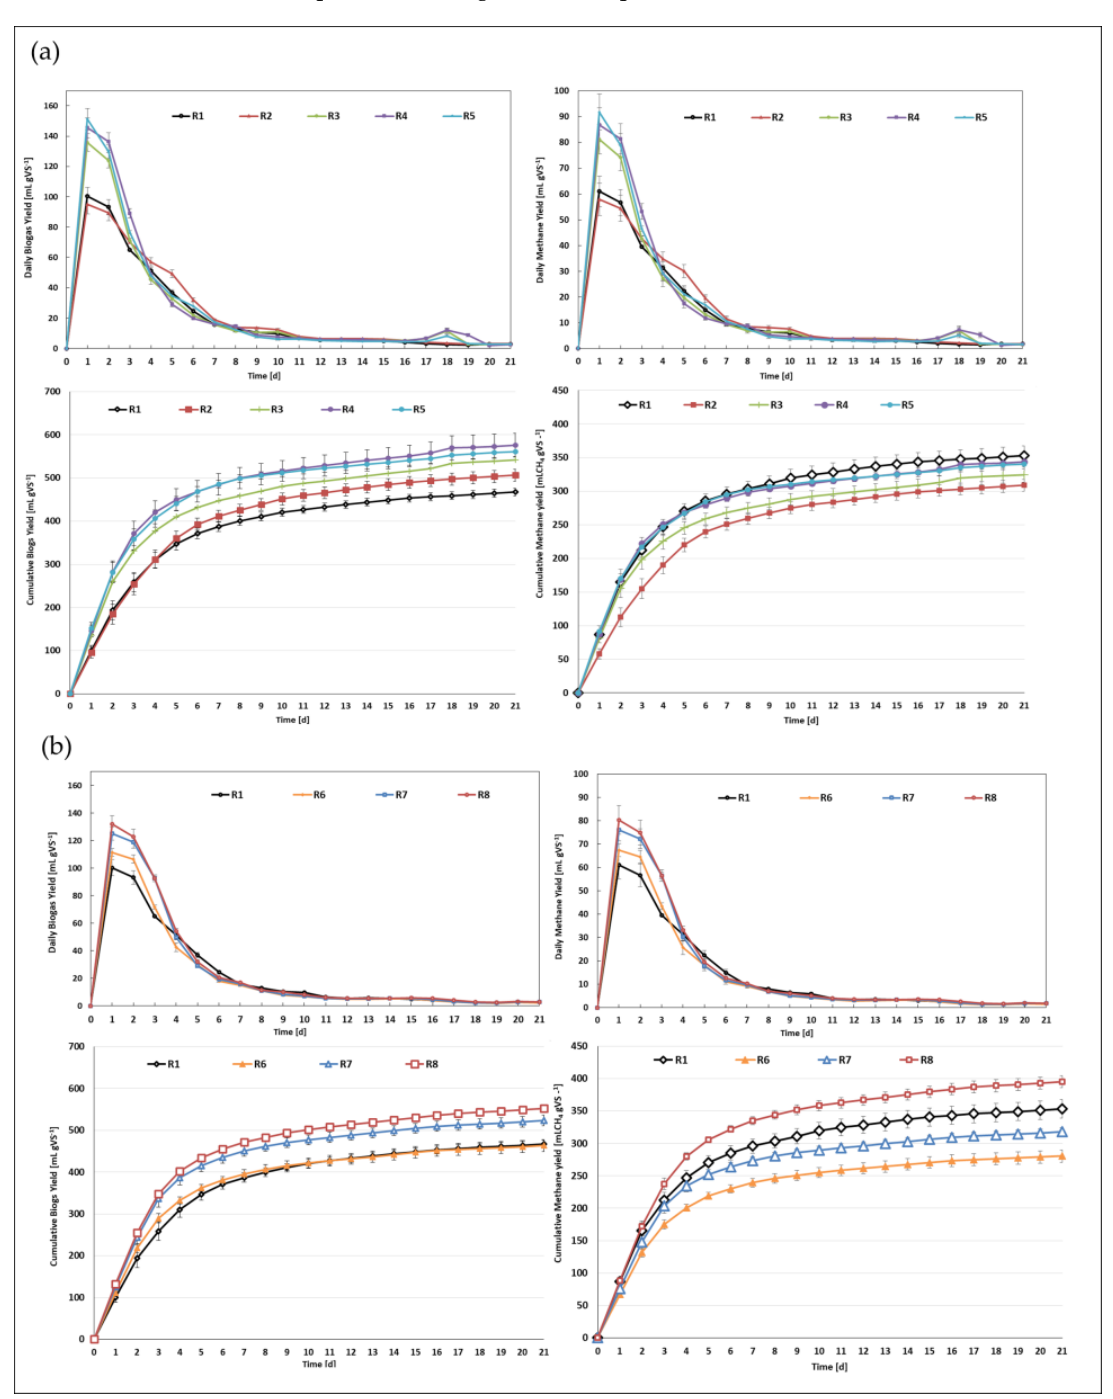
Figure 2. Daily biogas and methane yields, as well as cumulative biogas and methane productions in two- ( a ) and three- ( b ) component co-digestion series (average values and standard deviations are given).